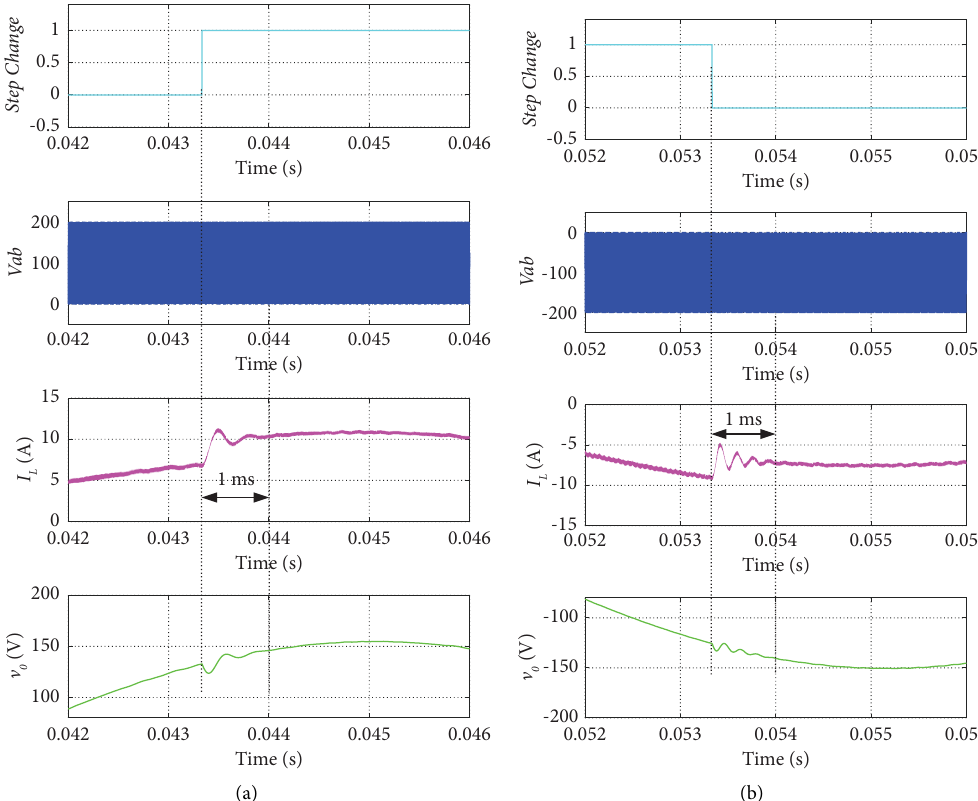
Figure 11: Transient response load current with linear control. (a) Step up from 7.8 A to 10.5 A at π /3. (b) Step down from 10.5 A to 7.8 A at 4 π